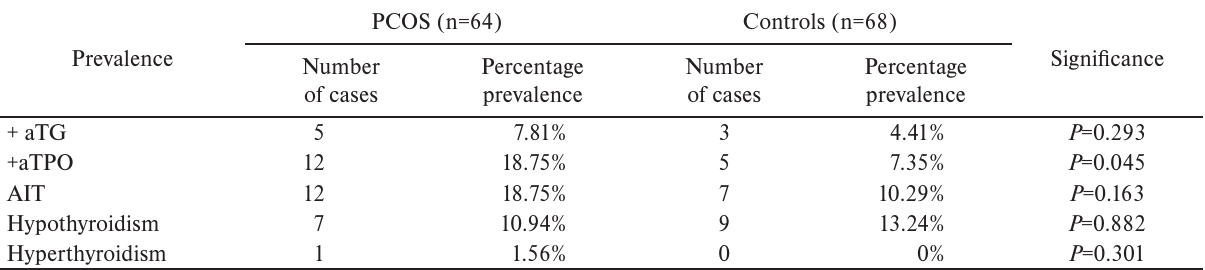
Table 3. Prevalence of antithyroid antibodies, AIT and thyroid dysfunction in PCOS women and